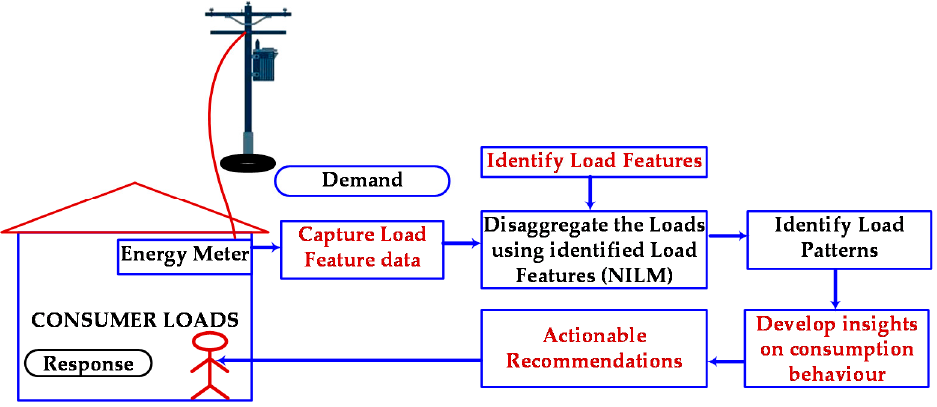
Figure 1. Schematic of Demand Response (DR) management.